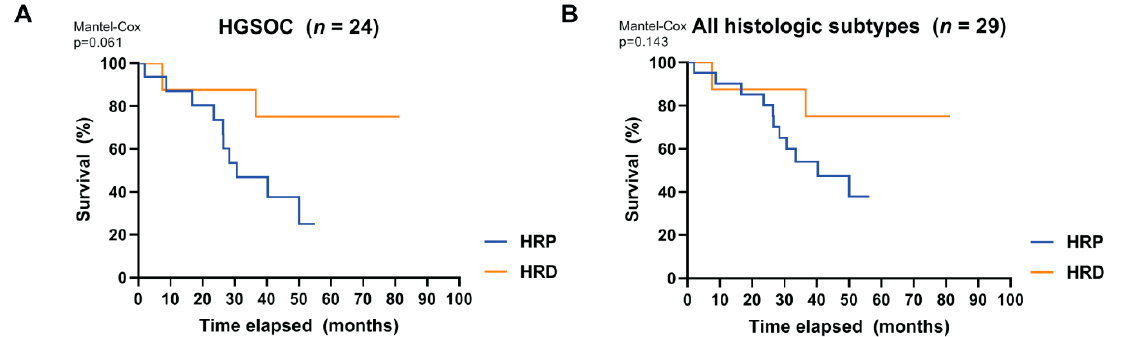
Figure 3. Overall survival of patients with high-grade serous ovarian carcinoma (HGSOC) only and diverse histologic subtypes. Kaplan–Meier estimates show the overall survival (%) over time (months) in a subgroup of patients whose tumors were analyzed by the RECAP test (see Materials and Methods).